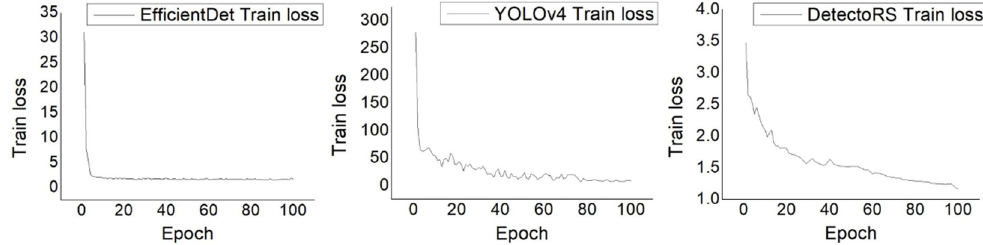
Figure 2. Loss curves of the training process.